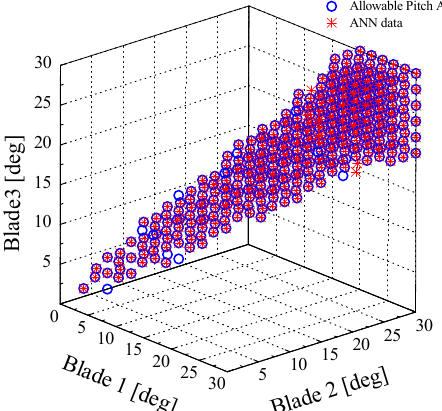
Figure 7. APA and ANN data for M a of 11 m/s.